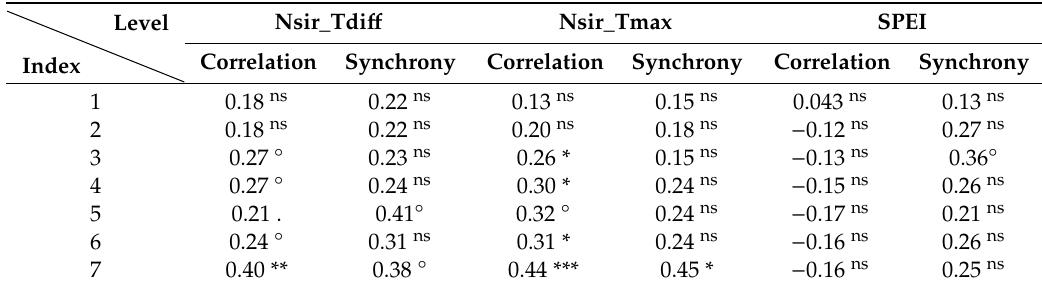
Table 1. Correlation coe ffi cients (and significance level 1 ) and fraction of low / upper synchrony between yearly burnt area anomaly and fire hazard indices modelled from the number of Sirocco events based on temperature anomalies three days before and during fire events (Nsir_Tdi ff ), temperature anomaly above the 33 ◦ C threshold (Nsir_Tmax) and the drought index Standardized Precipitation Evaporation Index (SPEI) (September). Levels indicate the temperature anomalies (in ◦ C) or the number of months used for SPEI